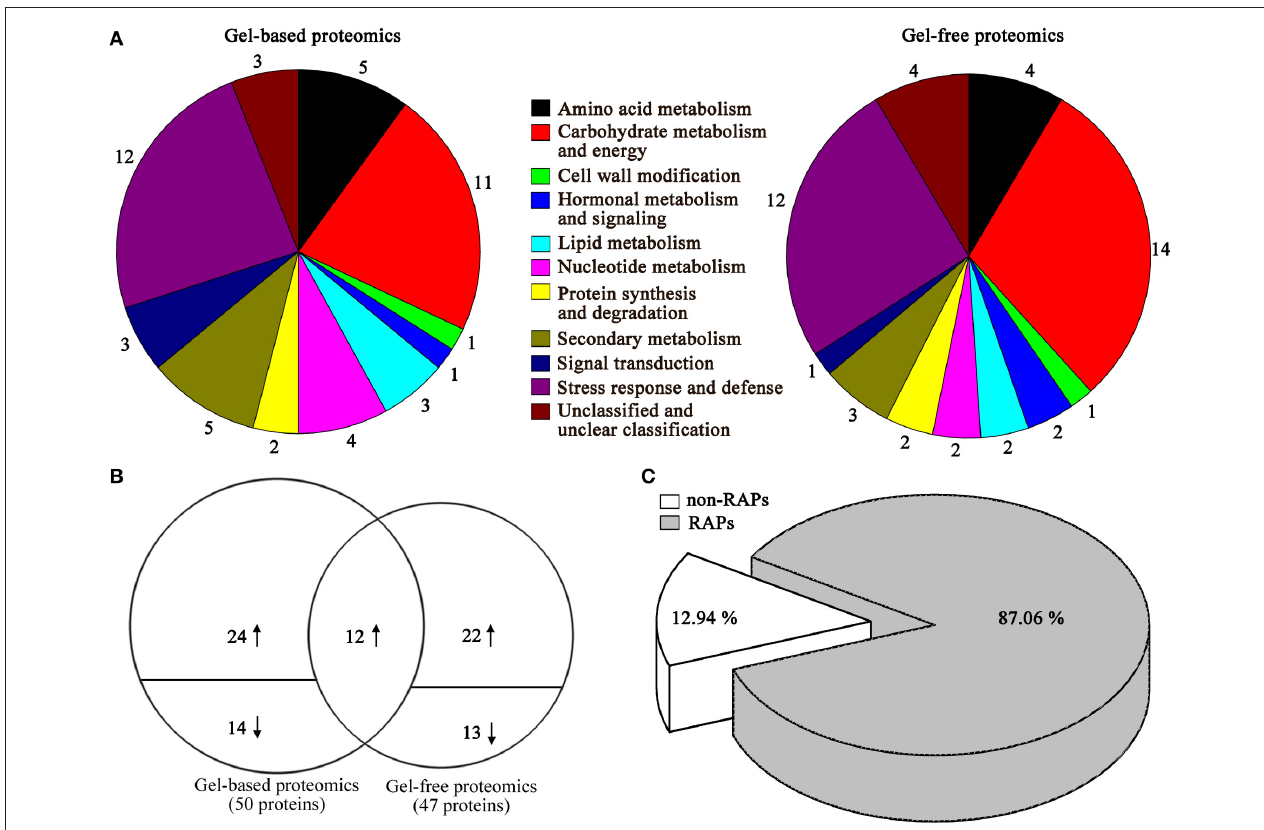
FIGURE 3 | Proteomic analyses of differentially expressed proteins between ALA treatment and the control in apple skin using gel-free and gel-based techniques. (A) Primary functional distribution of 50 and 47 regulated gene products as identified by gel-free and gel-based techniques. (B) Venn diagram of the distribution of differentially expressed proteins identified by gel-free and gel-based techniques. The number above or below the horizontal line in each portion indicated the number of up-regulated or down-regulated proteins. The overlapping regions indicated the number of proteins commonly identified by the two proteomics techniques. (C) Further classification was carried out to identify proteins related to previous studies orthologous ripening associated proteins